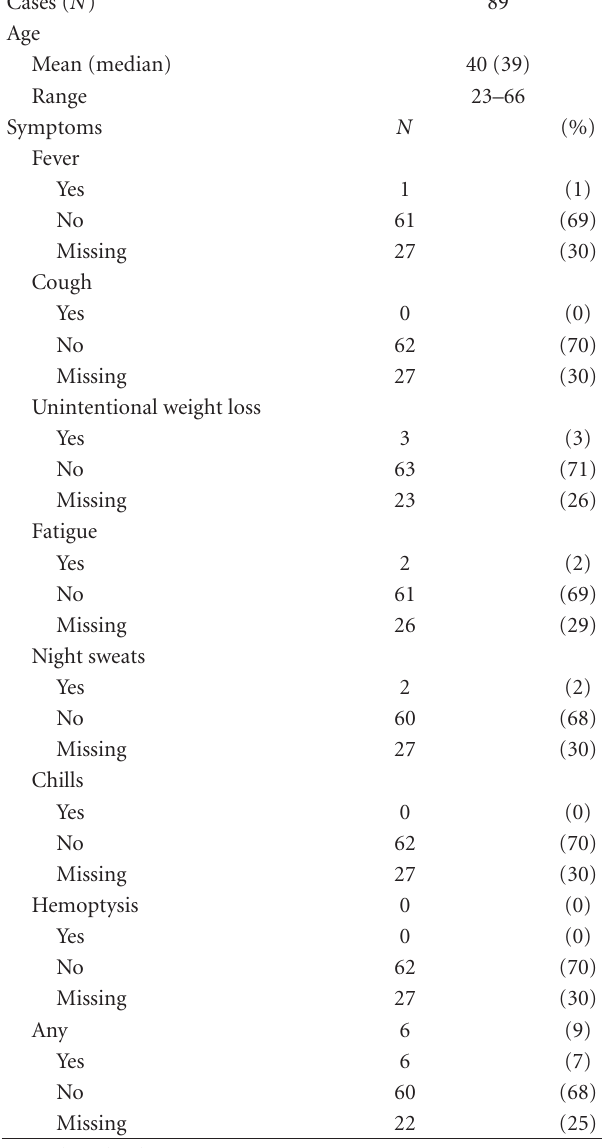
Table 2: Medical examination of 89 inmates with positive TSTs.